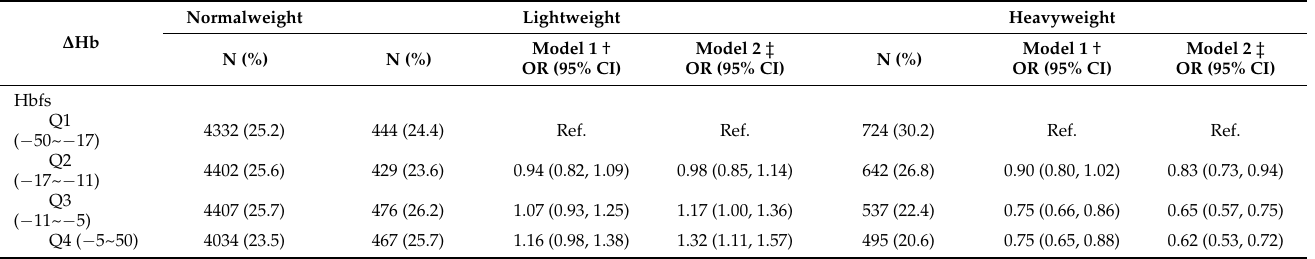
Table 3. Associations between change of maternal hemoglobin concentrations and adverse birth